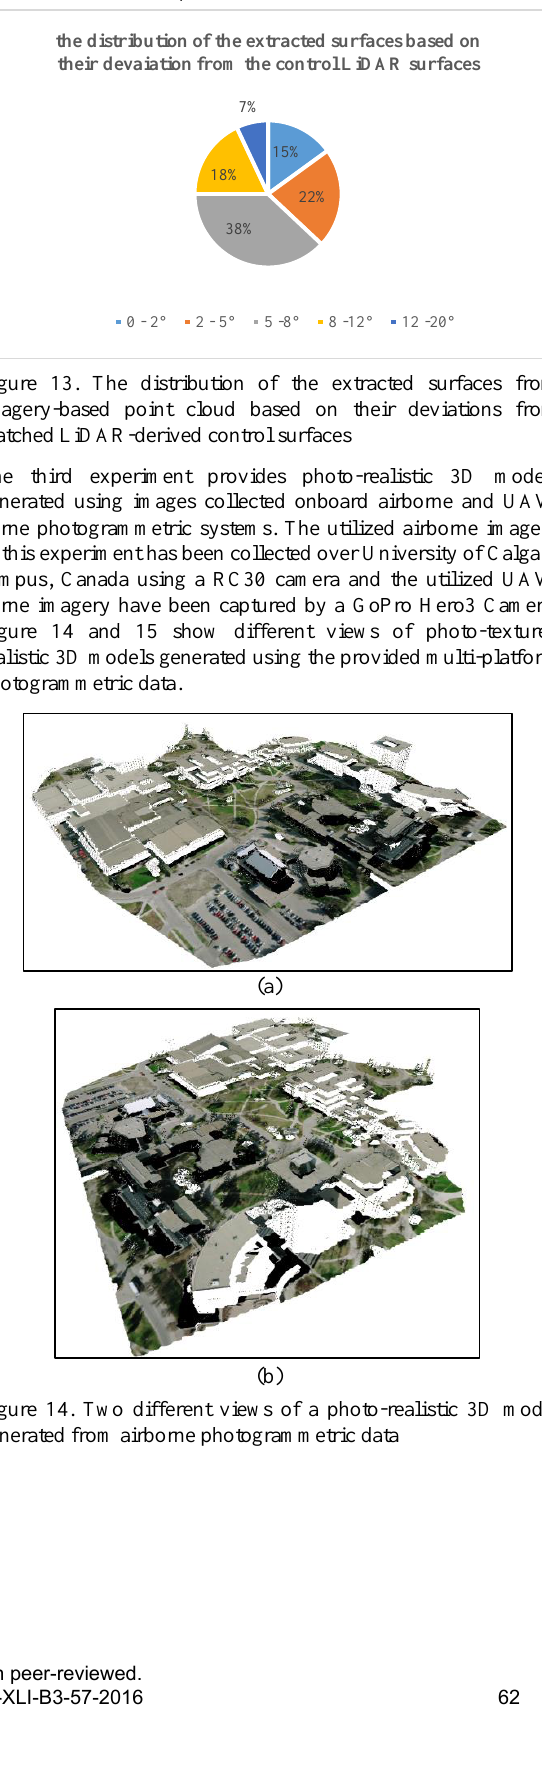
Figure 12. Comparative analysis of the quality of the extracted surfaces from: (a) LiDAR-based point cloud and (b) imagery- based point cloud